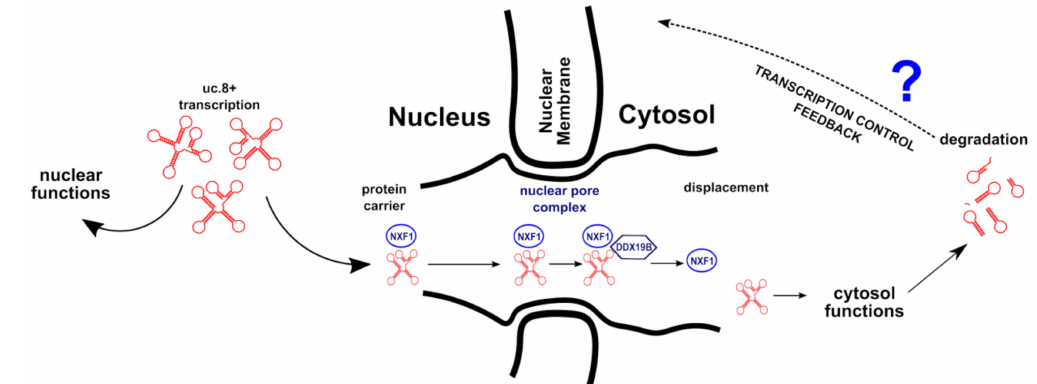
Figure 6. Hypothesized mechanisms of uc.8+ transcription and